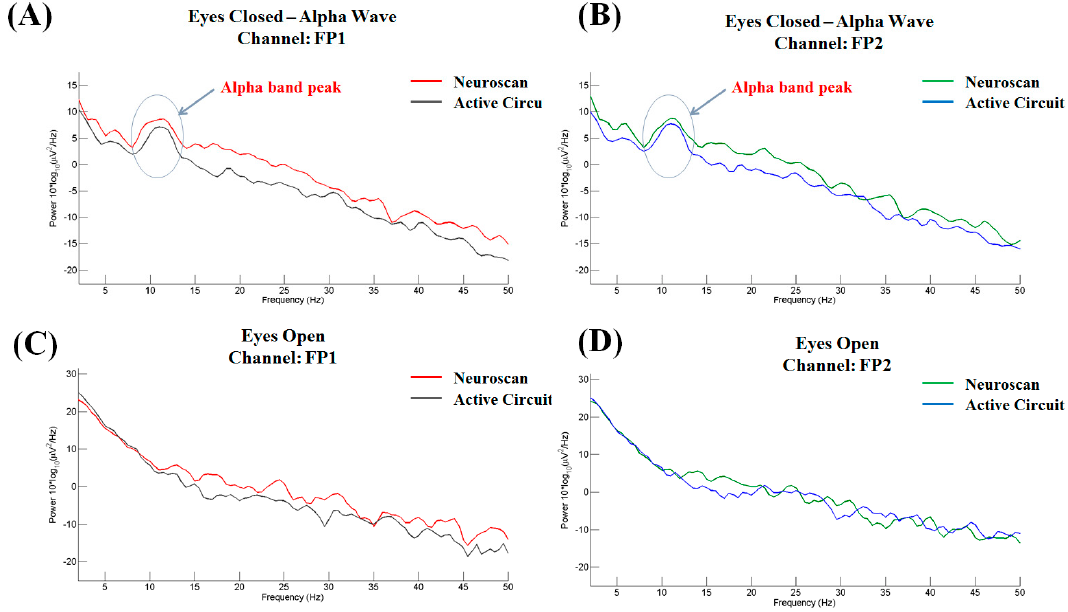
Figure 8. Power spectra in the eyes-closed condition: ( A ) FP1 and ( B ) FP2. Power spectra in the eyes-open condition: ( C ) FP1 and ( D ) FP2.